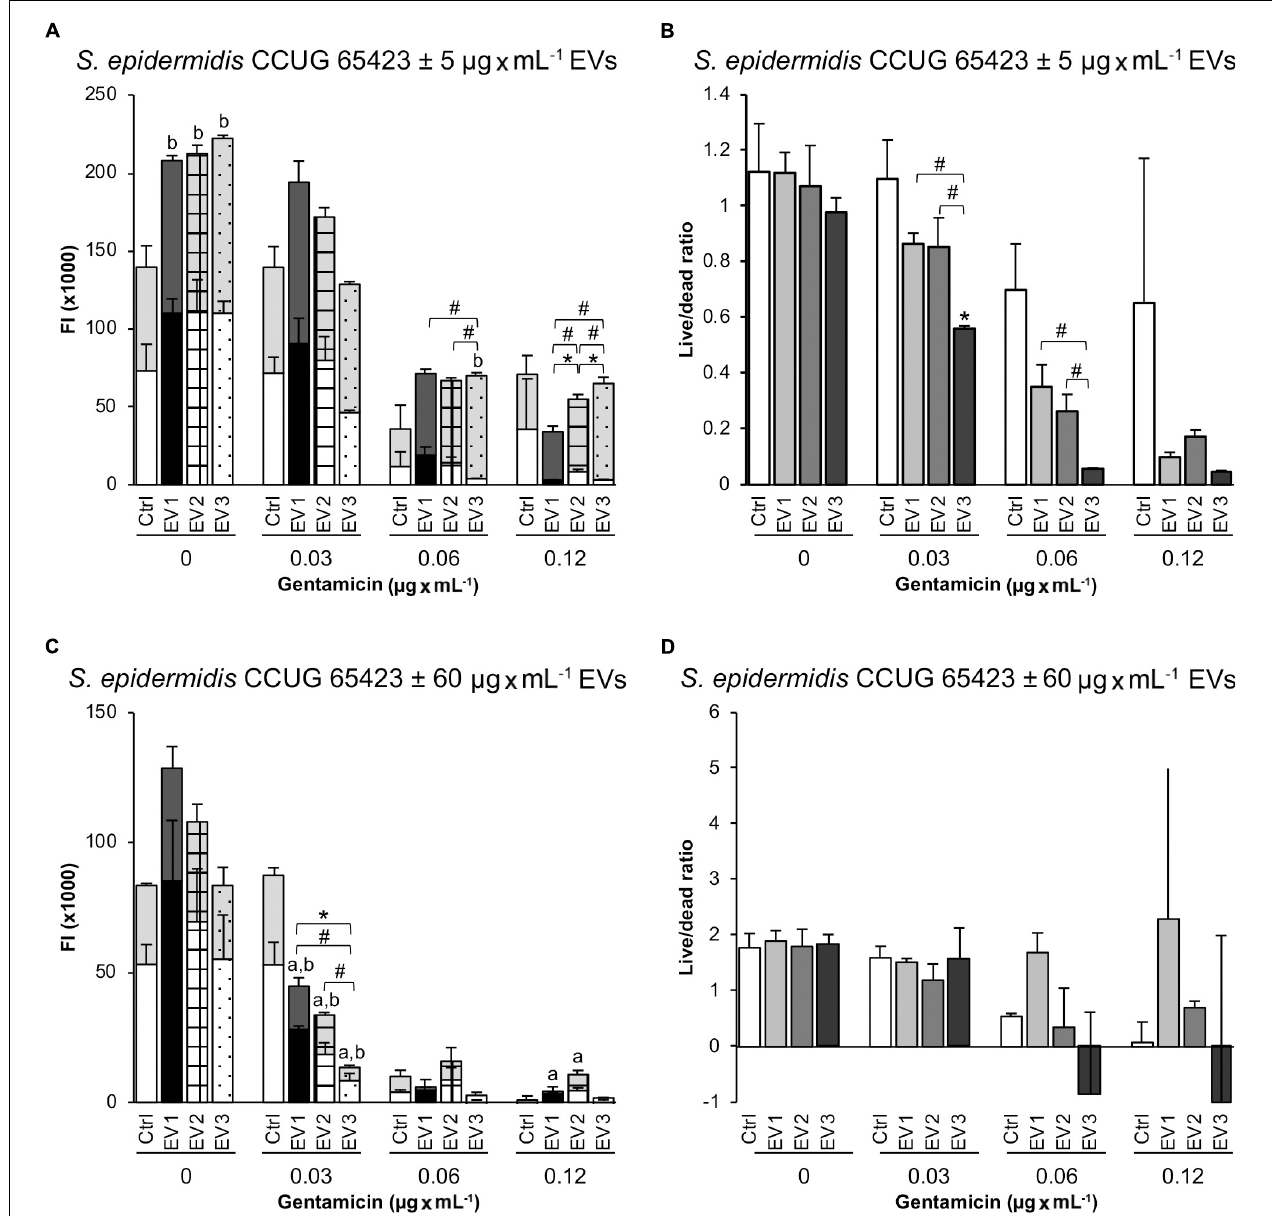
FIGURE 5 | Live and dead populations of planktonic Staphylococcus epidermidis after 18 h measured as fluorescence intensity (FI) in a plate reader. (A,B) Treatment with EVs (5 µ g × mL − 1 ). (C,D) Treatment with EVs (60 µ g × mL − 1 ). The data represent the mean ± SEM ( n = 3) of live and dead cells. Gray background bars (top) represent the dead population, and white background bars (bottom) represent the live population. Asterisks and hashtags indicate statistically significant differences between live and dead populations, respectively. Letters a (live population) and b (dead population) indicate a significant difference from the untreated Ctrl ( p <